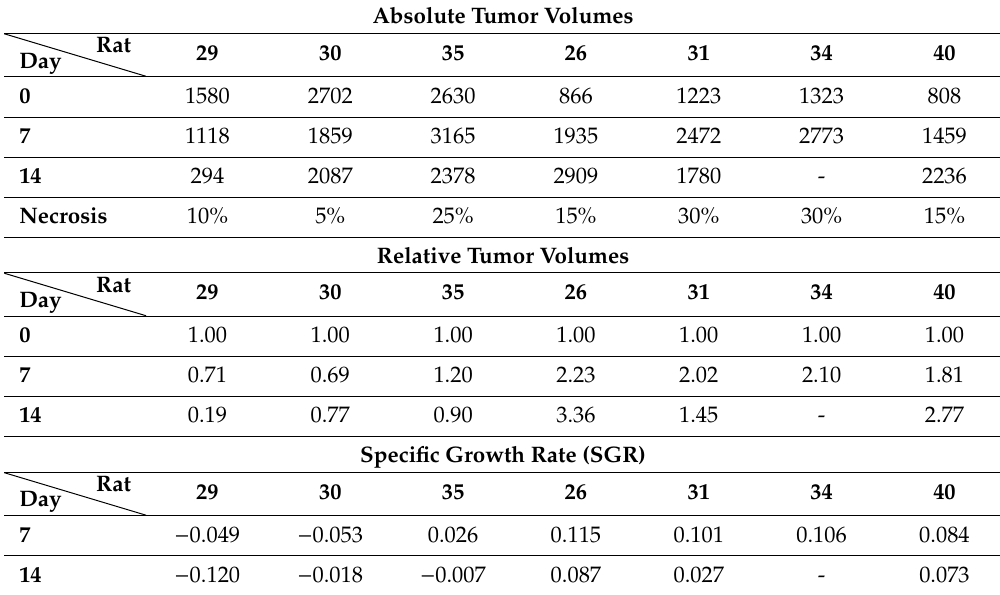
Table 3. Quantitative characterization of tumor growth for rats on W + Cur diet with EP + Cur treatment. The relative tumor volumes and SGR were calculated for days 7 and 14 after treatment, compared to the tumor volume before start of the treatment (at day 0).